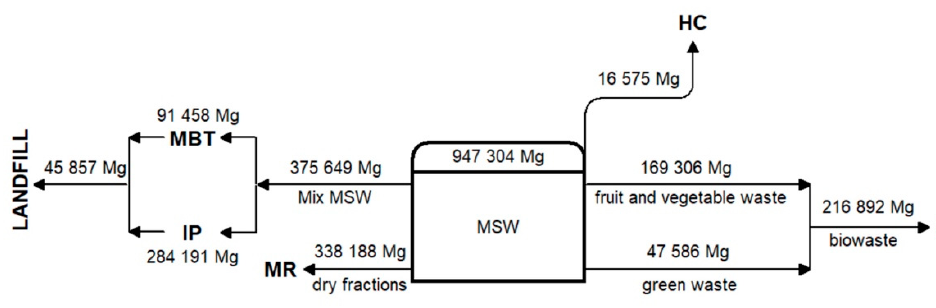
Table 5. TS ‐ II material flow of biowaste in recycling process and MSW recycling rate achieved. Units